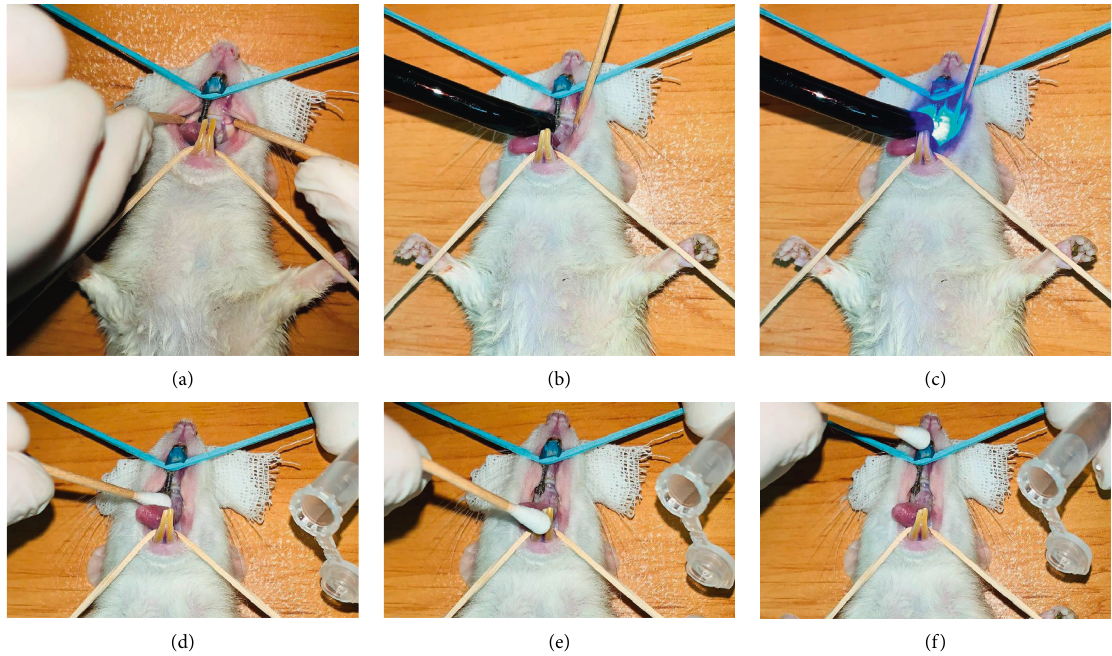
Figure 1: The aPDTand sampling procedures in the oral cavity of the rats with fixed orthodontic appliances: (a) Orthodontic appliance fixed in the oral cavity of the rat, (b) Before irradiation of LED during aPDT, (c) Irradiation of LED during aPDT, d-f) Sampling by a sterile swab drawn on the tooth and the contact area of the orthodontic appliance and